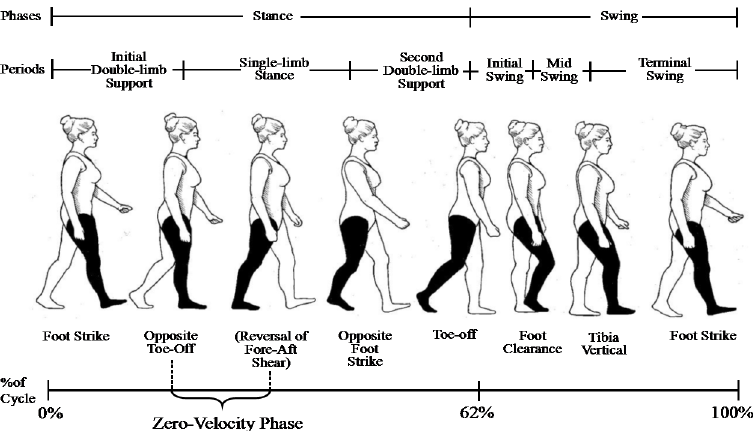
Figure 9. Normal gait cycle of pedestrian.